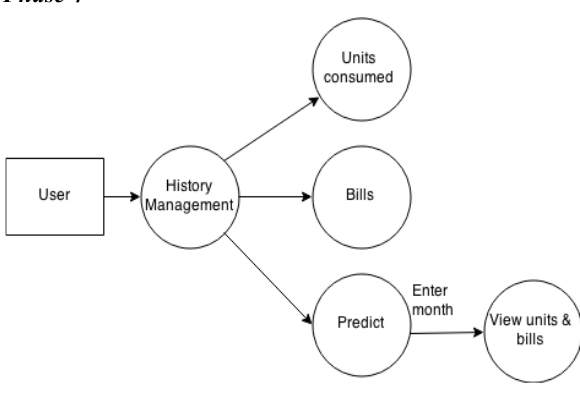
Figure 14. History Management for a user in Integrated System